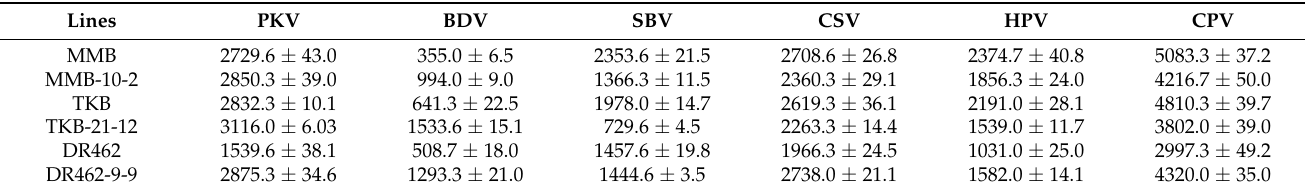
Table 3. RVA profile characteristics of rice starch mutant lines in the T 2 generation and their respective wild types.